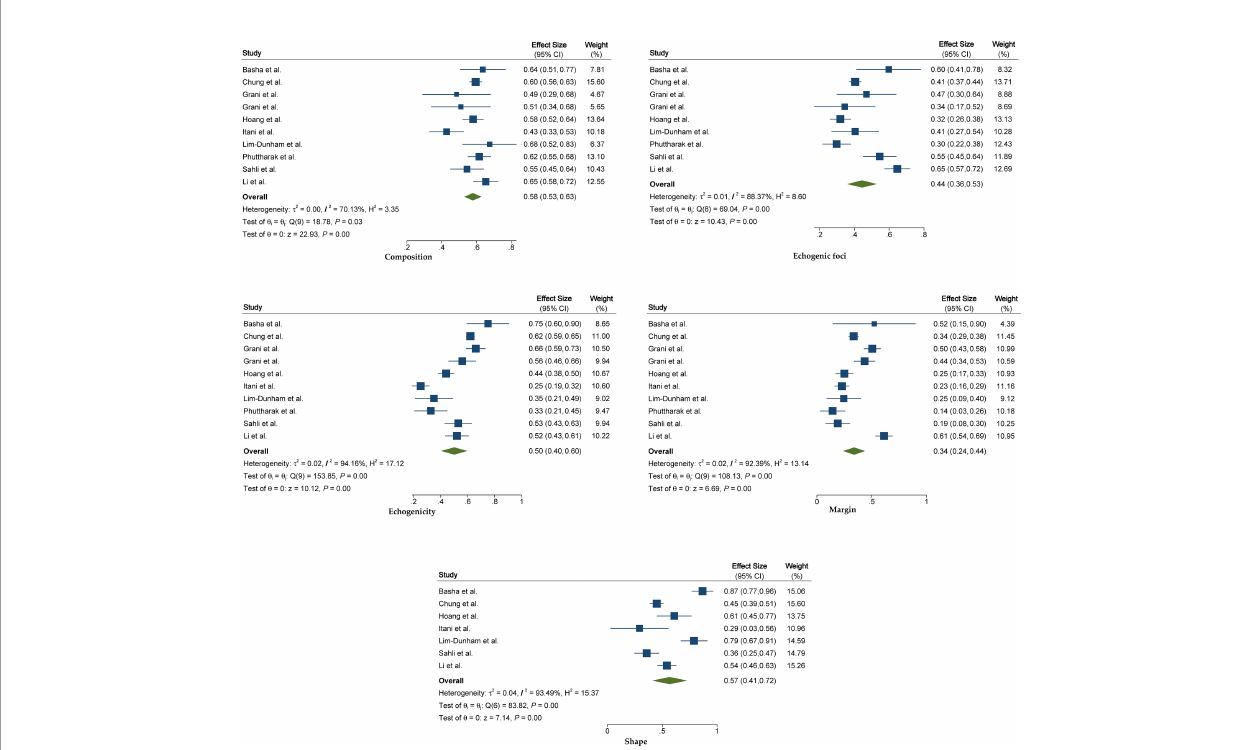
FIGURE 3 | The forest plot of pooled inter-reader agreement for fi ve US features recommended by the ACR TI-RADS. US, ultrasound; ACR, American College of Radiology; TI-RADS, Thyroid Imaging Reporting and Data System.